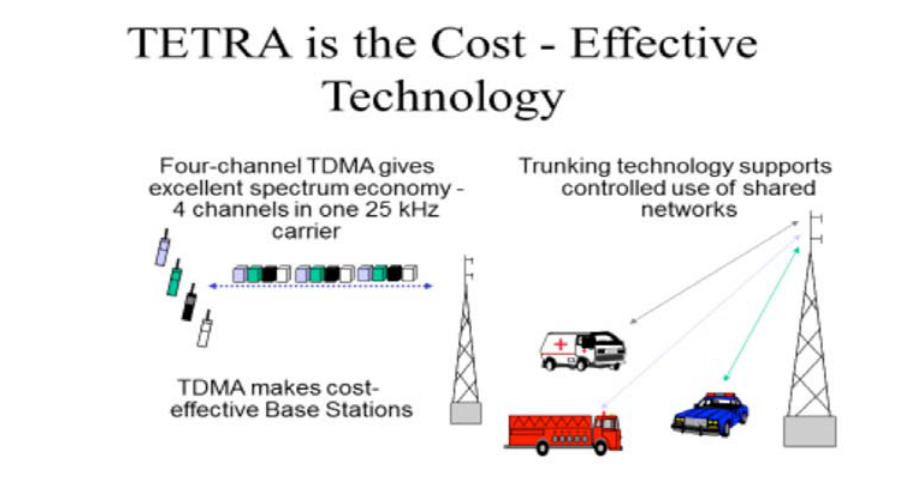
Figure 8 – Overview of simultaneous use of a unique TETRA 1 network for three different user groups (123seminarsonly,